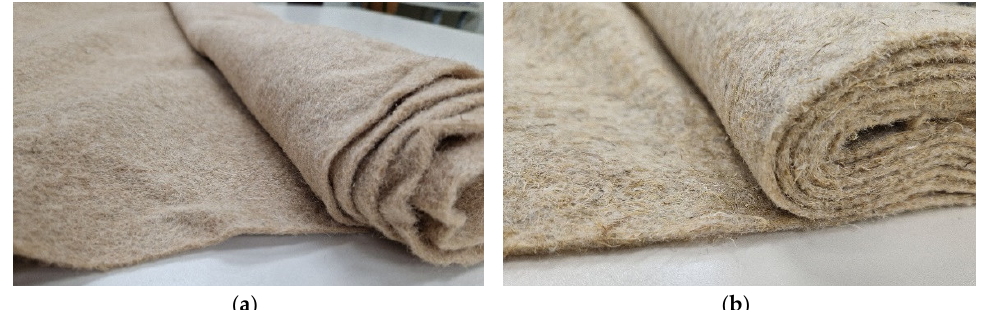
Figure 2. The nonwoven mulches produced by ( a ) jute and ( b ) hemp fibres.